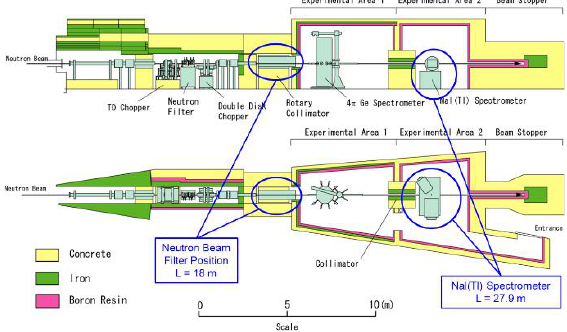
Fig. 2. Accurate Neutron Nucleus Reaction Measurement Instrument (ANNRI), and the positions of neutron beam filter system and NaI(Tl) spectrometer.